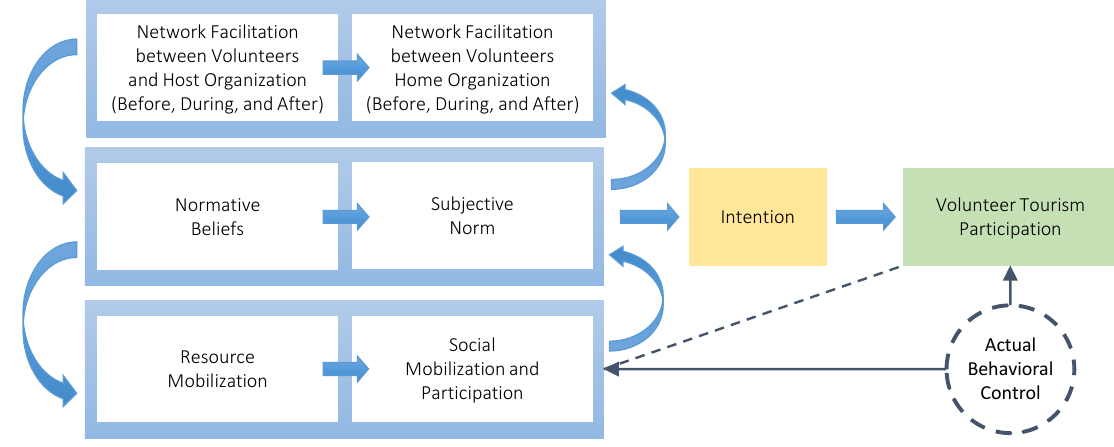
Figure 1. Conceptual framework of volunteer